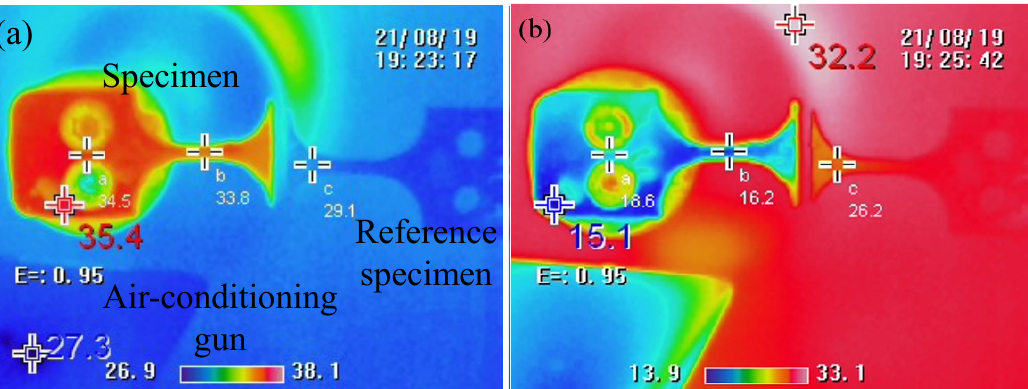
Figure 6. Thermal image of the specimen during resonance: ( a ) Without air-cooled; ( b ) air-cooled.